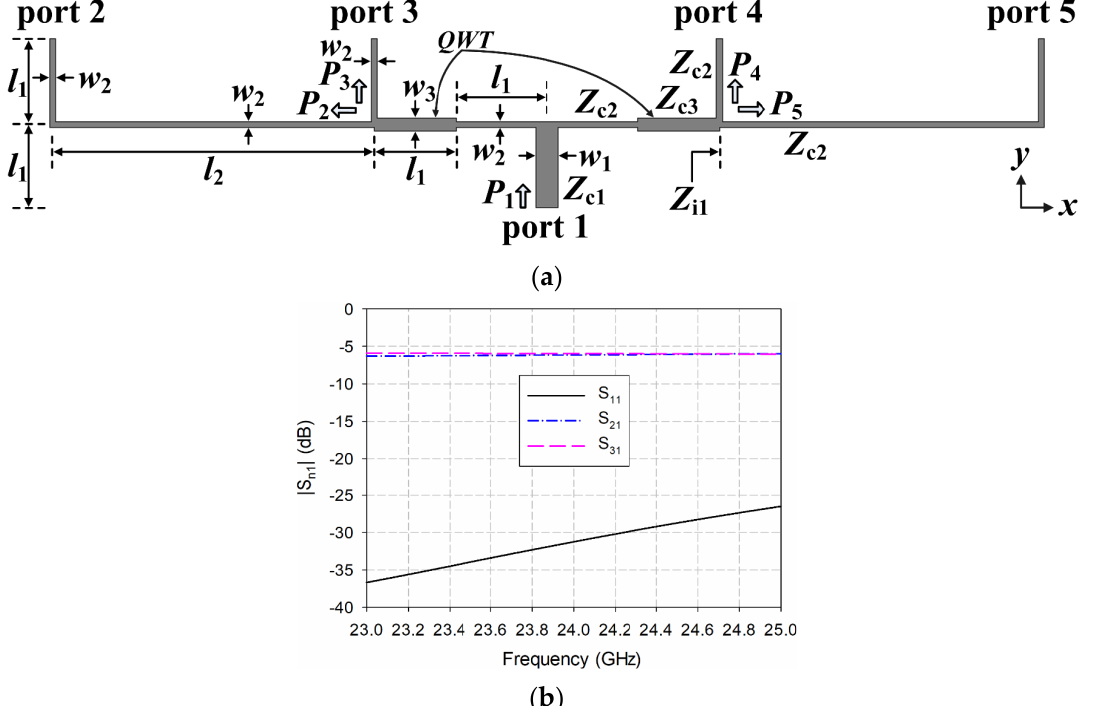
Figure 2. Geometry and scattering parameter characteristics of the 4 × 1 shunt-connected series feed network using a uniform power distribution: ( a ) the geometry and ( b ) scattering parameters.